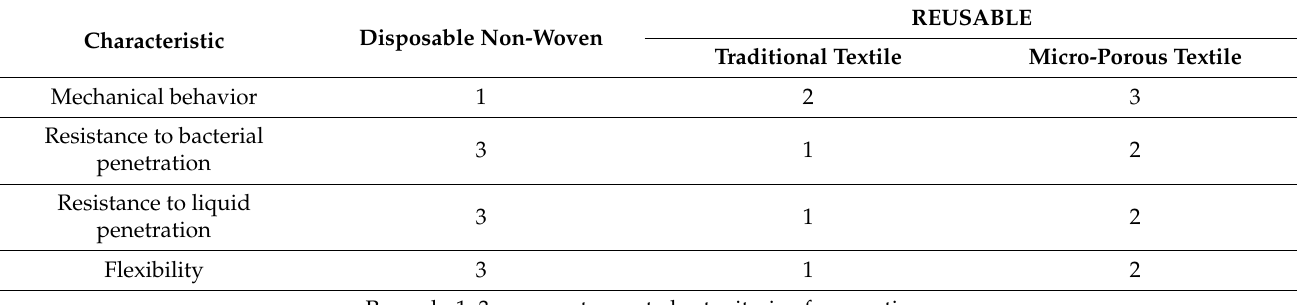
Table 1. Comparison between disposable and reusable textiles characteristics